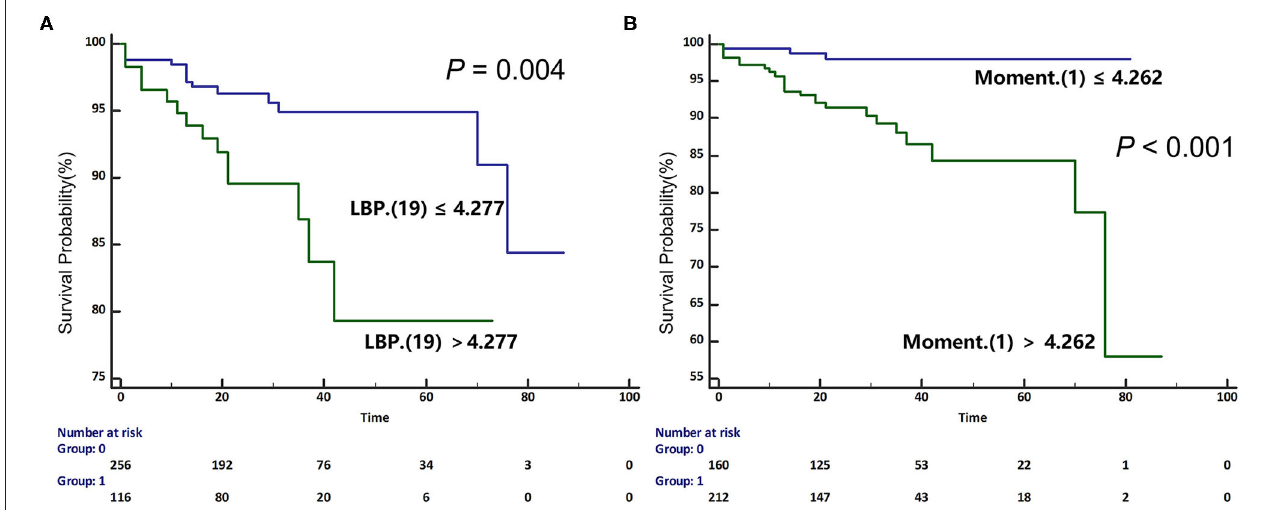
FIGURE 4 | Kaplan-Meier (KM) curves for predicting sudden cardiac death endpoint in participants with HCM based on the median values of selected radiomics features [ A. Local binary patterns (LBP) (19); B . Moment (1)]. HCM, hypertrophic cardiomyopathy; SCD, sudden cardiac death.